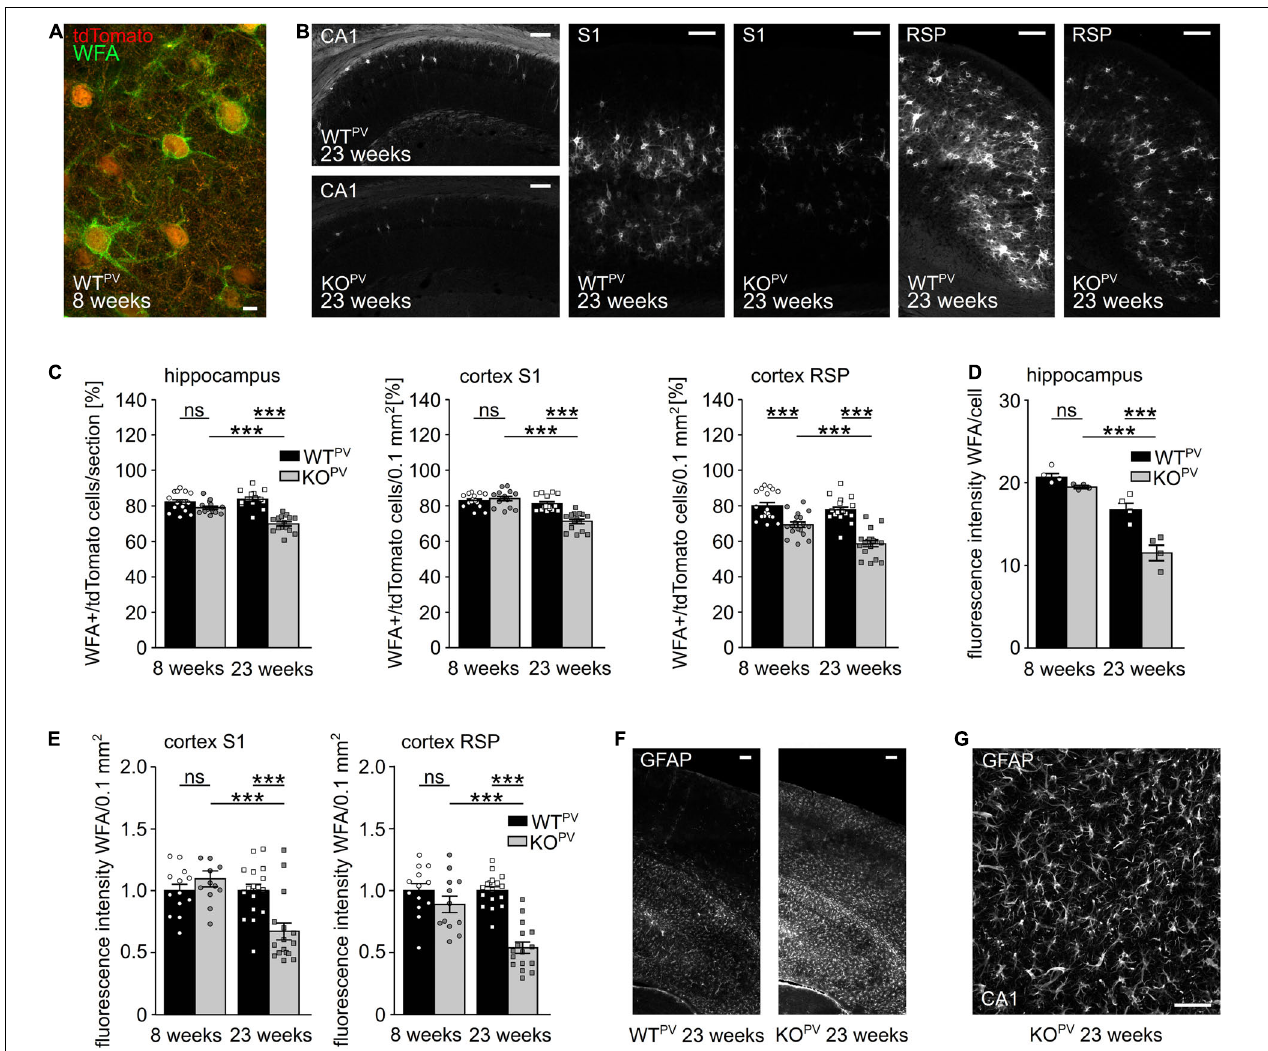
FIGURE 6 | Perineuronal networks (PNN) decrease in KCC2 KO PV mice. (A) Representative WFA stainings of the somatosensory cortex of a WT PV mouse at the age of 8 weeks. Scale bar 5 µ m. (B) Representative WFA stainings of the hippocampus (left), the S1 (middle) and RSP cortex (right) of WT PV and KCC2 KO PV mice at 23 weeks of age. Scale bars 100 µ m. (C) Quantification of WFA + /tdTomato cells in the hippocampus (left), S1 (middle), and RSP (right) cortex of WT PV and KCC2 KO PV mice at the age of 8 and 23 weeks shows a reduced proportion of ensheathed PV-INs in older KO PV mice ( n = 15/15 slices, N = 5/5 mice; 1-way ANOVA; Bonferroni’s multiple comparison test; ns not significant; *** p < 0.001). (D,E) WFA signal intensity per individual cell in the hippocampus (D) ( n = 12/9 slices; N = 4/3 mice; 1-way ANOVA; Bonferroni post-test; ns not significant; *** p < 0.0001). WFA signal intensity per 0.1 mm 2 in the S1 cortex (left) and RSP (right) decreases over time in KCC2 KO PV mice ( n = 13/15 slices; N = 5/5 mice; 1-way ANOVA Bonferroni post-test; ns not significant; *** p < 0.0001). (F) Representative GFAP staining of the cortex and hippocampus of WT PV and KCC2 KO PV at the age of 23 weeks. Scale bar 100 µ m. (G) Close up of GFAP -stained reactive astrocytes in CA3 in KCC2 KO PV . Scale bar 50 µ